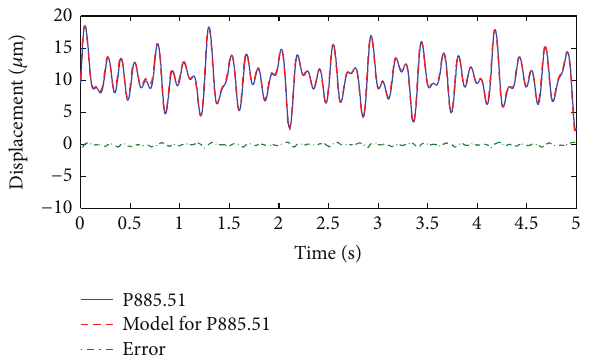
Figure 10: Time histories of the output displacements from P885.51 with nonperiodic voltage measured by the LDV and predicted by the modified comprehensive model and the modeling error.